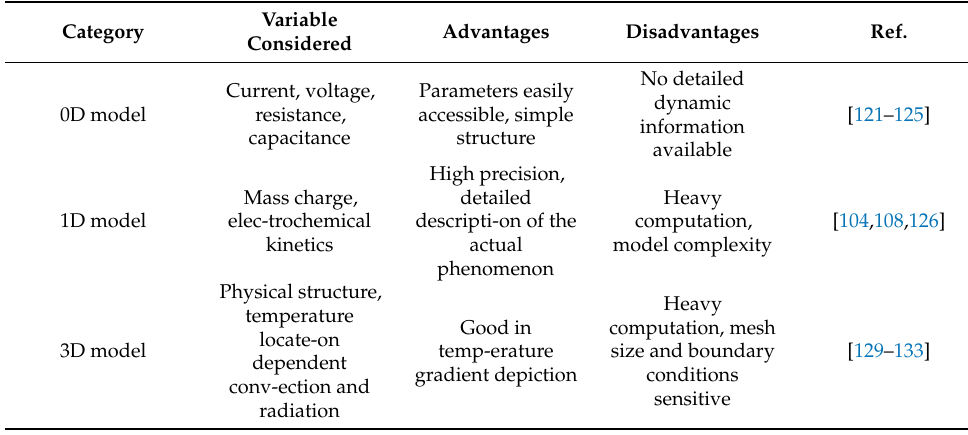
Table 4. Summary of various SC thermal modeling methods by